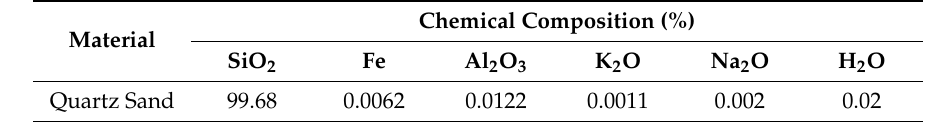
Table 3. The chemical composition of quartz sand.